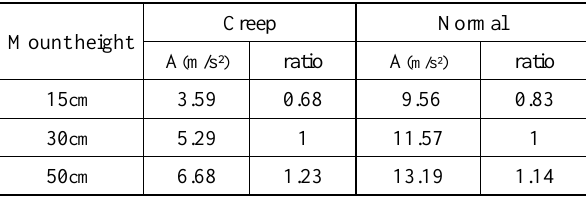
Table 1. Experimental results by